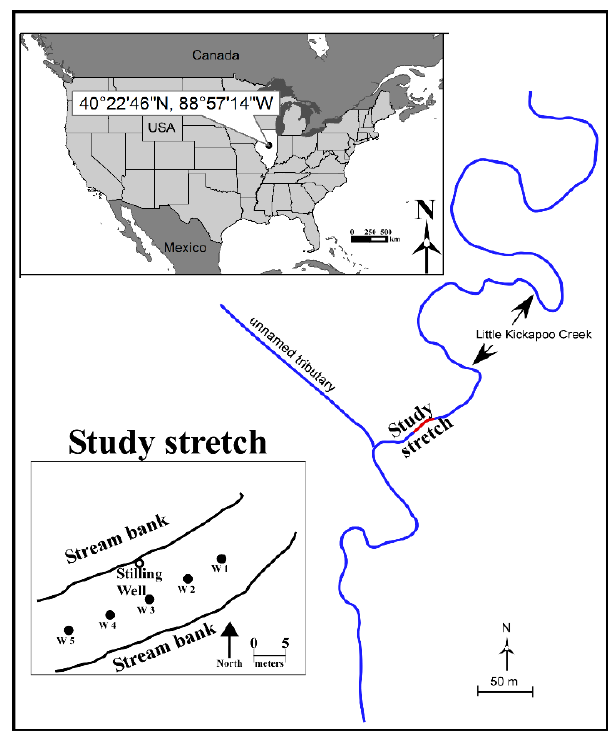
Figure 1. Location figure showing the study stretch of Little Kickapoo Creek (LKC) with the positioning of the multilevel samplers and the stilling well (SW) in the stream channel. The inset shows the continental US highlighting the location of the study area.